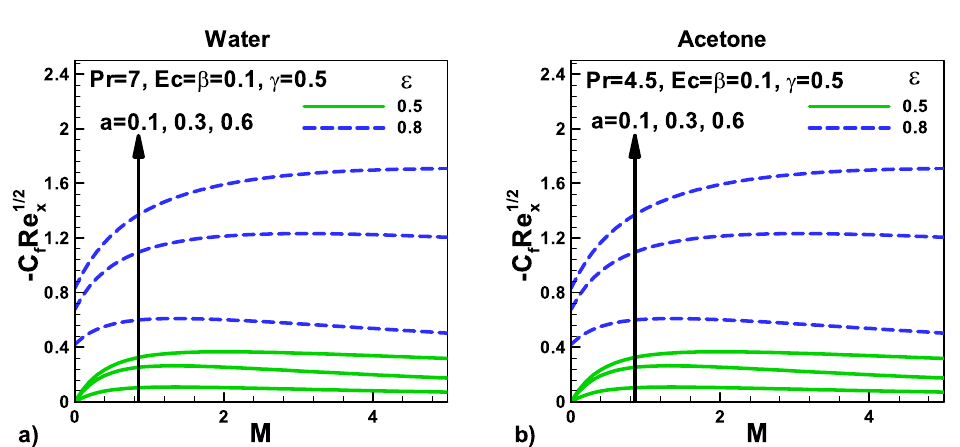
Figure 6. Variation of skin friction with magnetic field and velocity ratio parameter at different positions for ( a ) water ( b ) Acetone.